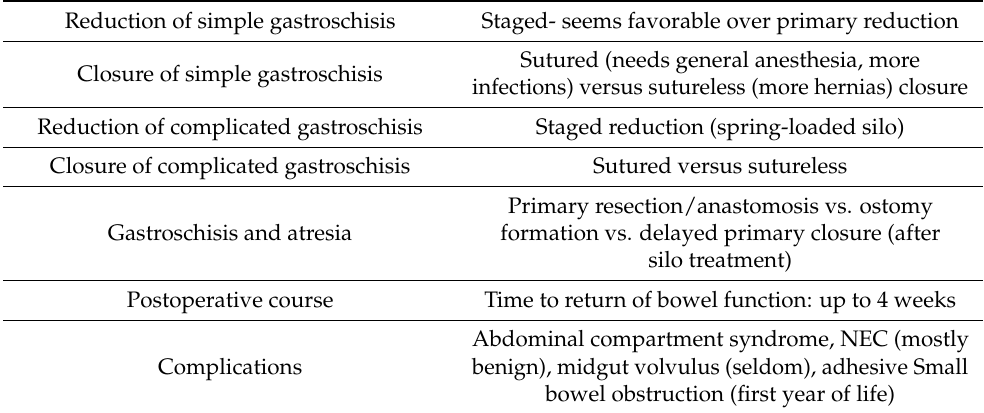
Table 2. Gastroschisis treatment. Reduction of simple gastroschisis Staged- seems favorable over primary reduction Sutured (needs general anesthesia, more Closure of simple gastroschisis infections) versus sutureless (more hernias) closure Reduction of complicated gastroschisis Staged reduction (spring-loaded silo) Closure of complicated gastroschisis Sutured versus sutureless Primary resection/anastomosis vs. ostomy Gastroschisis and atresia formation vs. delayed primary closure (after silo treatment) Postoperative course Time to return of bowel function: up to 4 weeks Abdominal compartment syndrome, NEC (mostly Complications benign), midgut volvulus (seldom), adhesive